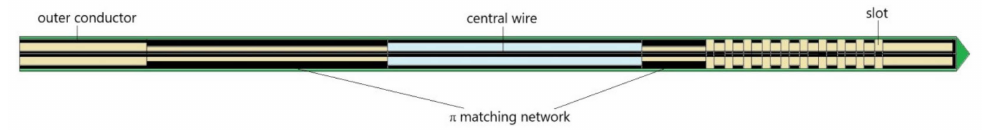
Figure 1. Schematic view of the 10-slot microwave antenna with an impedance π -matching network. The conducting material, Teflon, air, and dielectric are represented by black, green, light blue, and light brown, respectively. The width of the slot is 0.6 mm with a spacing of 0.8 mm between adjacent slots.